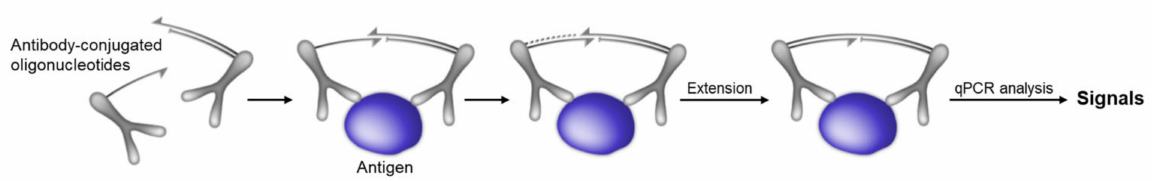
Figure 3. Conceptual scheme of proximity extension assays (PEA) for the detection of biomolecules such as antigens. Reproduced by permission of Oxford University Press: Nucleic Acids Res. 2011, 39, e102, doi:10.1093/nar/gkr424. Copyright (2011) [29].